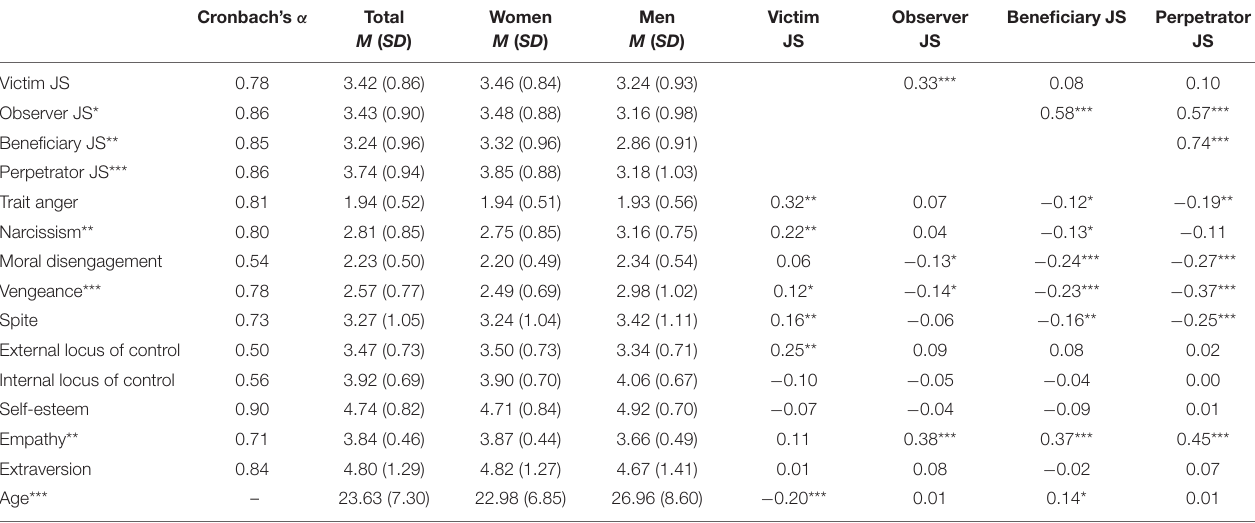
TABLE 2 | Descriptive statistics for JS facets and control variables and correlations between JS facets and control